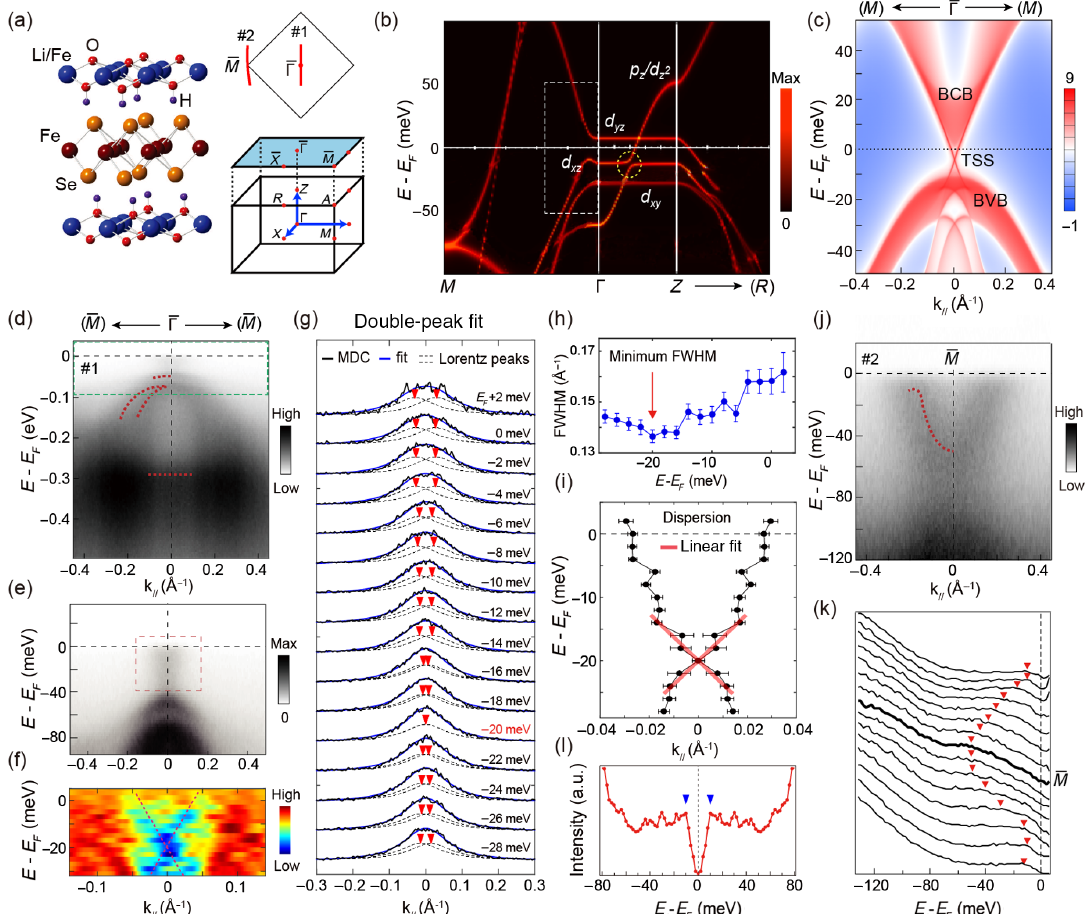
FIG. 1. Band structure and topological surface states of ð Li 1 − x Fe x Þ OHFeSe. (a) Crystal structure (left), surface Brillouin zone (upper right), and schematic of the projection from the 3D to 2D Brillouin zone on the (001) surface (lower right) of ð Li 1 − x Fe x Þ OHFeSe. Þ OHFeSe along the M - Γ - Z - ð R Þ direction, represented by spectral functions calculated by DFT (b) Band structure of ð Li 0 Fe 0 . 75 . 25 combined with DMFT methods [more extended band structure is shown in Fig. S1(a)]. The dashed circle indicates the small SOC gap at the crossing point of Se 4 p z and Fe 3 d xz bands. The dashed rectangle corresponds to the left half of the energy-momentum range of ¯ Γ − ¯ M panel (c). (c) Calculated bulk and surface states on the (001) surface along the direction, illustrated by the spectral function. ¯ Γ Dirac-cone-like topological surface states (TSS) centered at connect the bulk valence band (BVB) and conduction band (BCB). The BVB and BCB are mainly composed of 3 d xz and 3 d yz orbitals along this direction, respectively. (d) Photoemission intensity of Þ OHFeSe measured across ¯ Γ along cut #1 in panel (a). The dashed curves show the bulk band structure determined by ð Li 0 . 84 Fe 0 . 16 second derivatives. The green dashed rectangle corresponds to the energy-momentum range of panel (e). (e) An enlargement of data in ¯ Γ point. Finite spectral weight can be clearly observed within the bulk band gap. (f) Second derivative of the panel (d) near E F at the photoemission intensity in the marked region of panel (e), where a Dirac-cone-like dispersion can be seen. (g) Momentum distribution curves (MDCs) of the data in panel (e) in the energy range of − 28 meV – 2 meV (normalized by the intensity near k == ¼ 0 ). Red markers indicate the Dirac-cone-like dispersion extracted from the two-Lorentzian-peak fitting (blue and dashed curves). (h) The FWHM obtained from the one-peak fit [shown in Fig. S2(a)], as a function of energy. Error bars represent 95% confidence bounds. (i) E - k dispersion extracted from the two-peak fit in panel (g), and the linear fit around the crossing point. Error bars represent 95% confidence ¯ M bounds of the fitted peak position. (j) Photoemission intensity taken along cut #2 across in panel (a). The dashed curve shows the dispersion of the bulk electron band. (k) The energy distribution curves (EDCs) of the data in panel (j) after dividing by Fermi-Dirac distribution. (l) Symmetrized EDC near the Fermi crossing of the M pocket, where a superconducting gap of around 10 meV is observed (indicated by red arrows). All the data were measured at 5.6 K using 21.2-eV